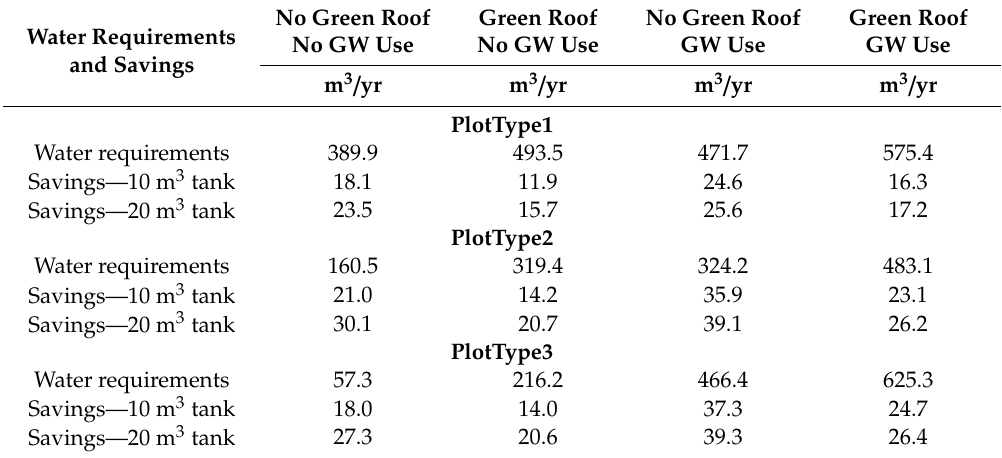
Table 4. Average annual water requirements for irrigation and greywater (GW) use and savings that can be achieved with the installation of a 10 and 20-m 3 tank, for